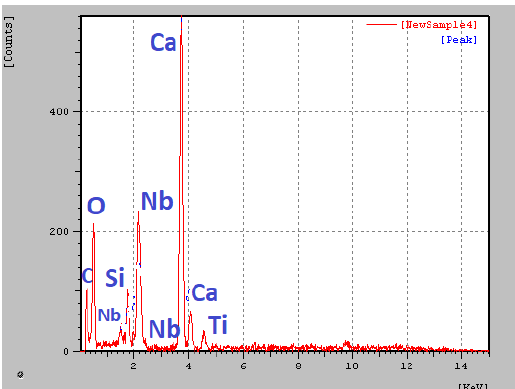
Figure 17- DES analysis of the permeable concrete surface with 10% TiO 2